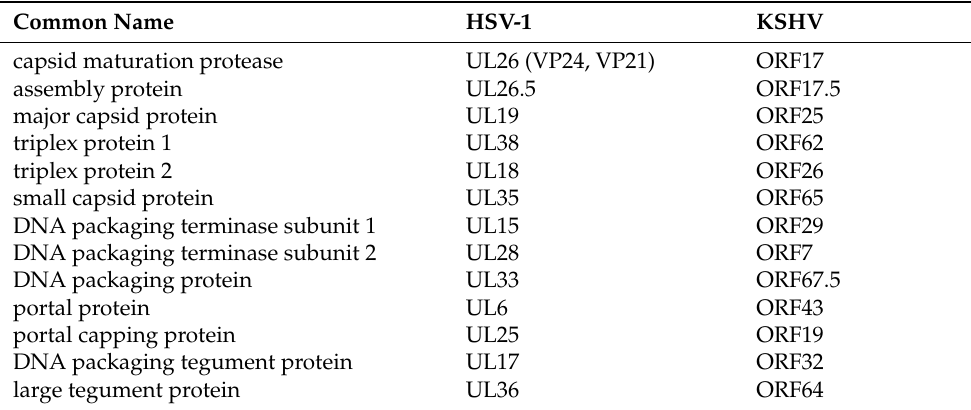
Table 1. Capsid and capsid-related molecules of HSV-1 and